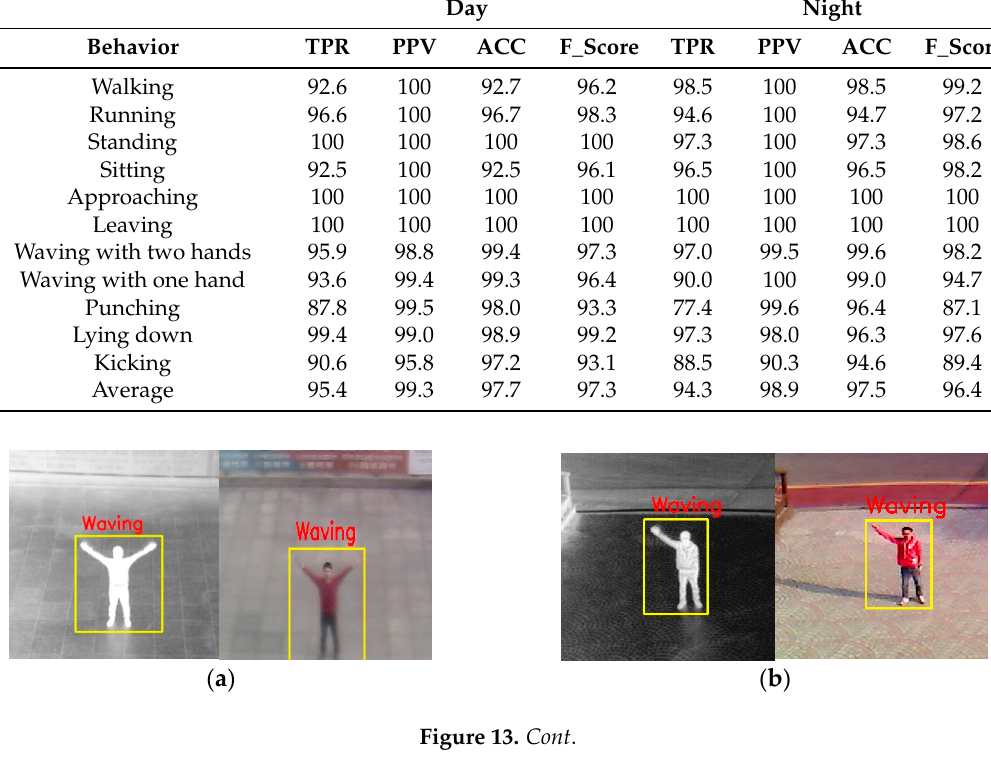
Table 5. Accuracies of behavior recognition by our method (unit: %).